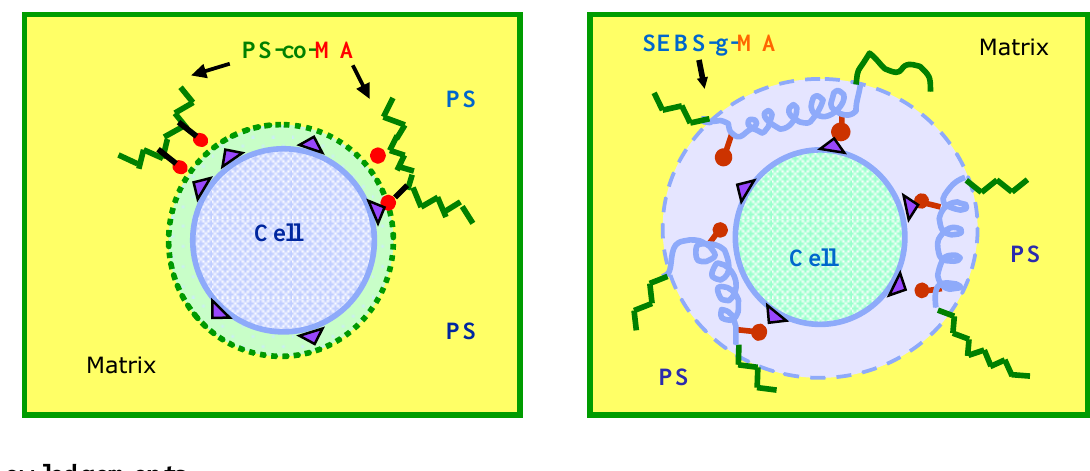
Figure 19. Effect of compatibilizer structure on the polymer-fiber interactions at the interface in PS/Cell composites